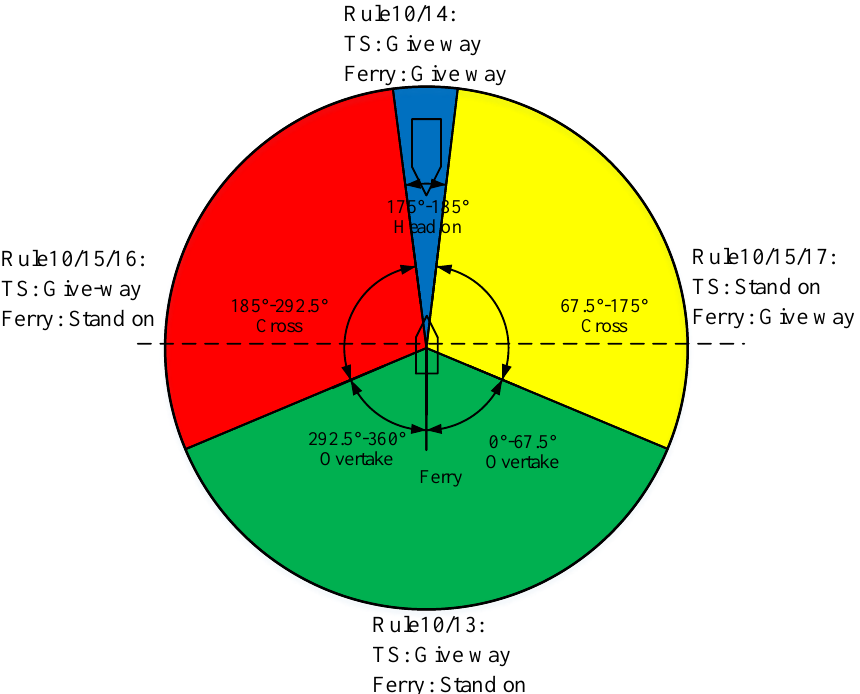
Figure 1. Ferry’s collision avoidance responsibility according to COLREGs.